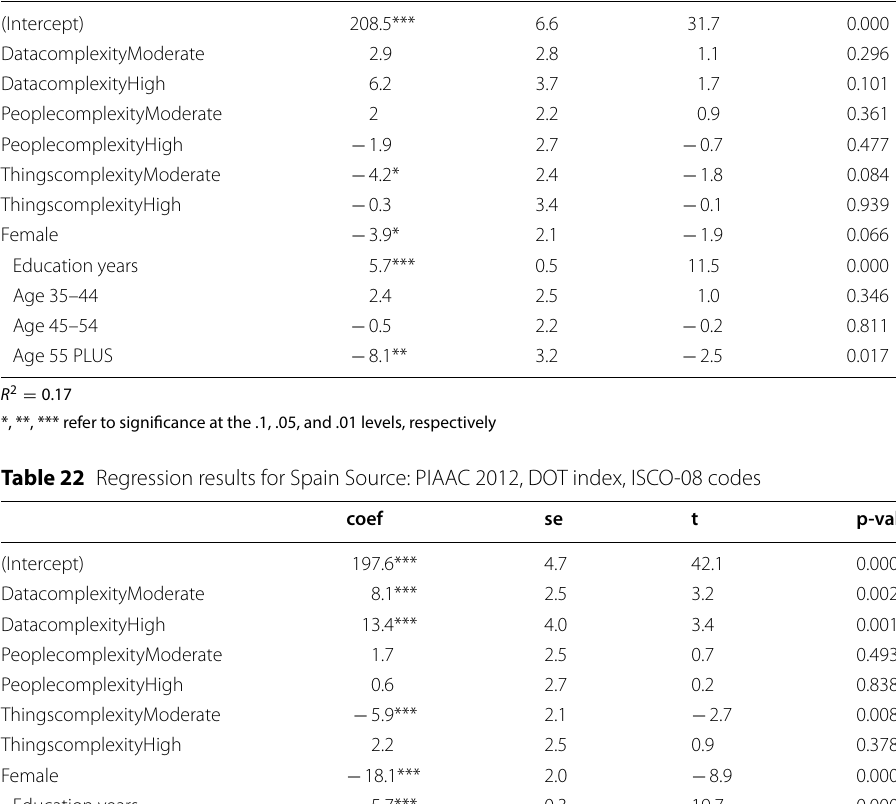
Table 21 Regression results for Slovak Republic. Source: PIAAC 2012, DOT index, ISCO-08 codes